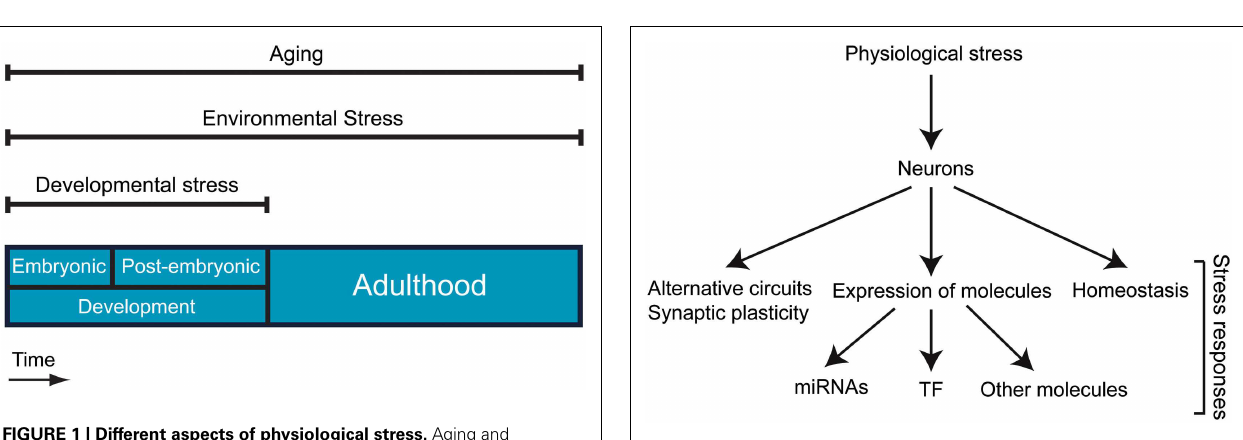
FIGURE 2 | Stress triggers biological responses in different levels of organization. The different molecules involved dictate the changes required for adaptation, and therefore survival and reproduction.TF, transcription